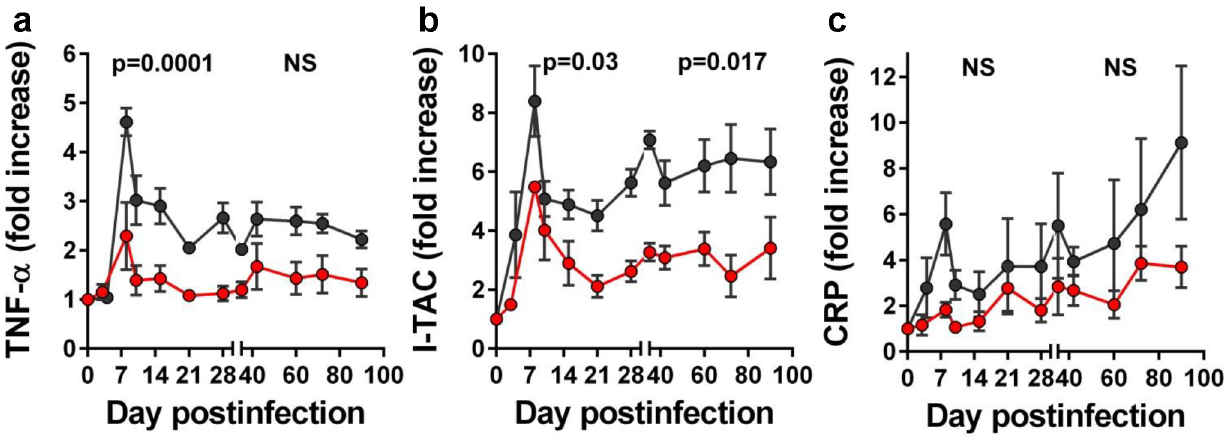
Fig 4. Rifaximin (RFX) + sulfasalazine (SFZ) therapy impacts the levels of inflammation during acute and early chronic SIVsab infection of pigtailed macaques (PTMs). Levels of proinflammatory cytokines were consistently lower in SIVsab-infected PTMs receiving RFX+SFZ (red) compared to untreated controls (black): (a) TNF- α ; (b) I-TAC; and (c) C-reactive protein (CRP). Shown are the average values for each group and standard error of means.